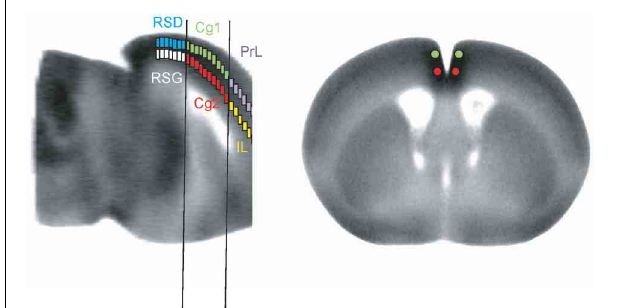
FIGURE 1 | Representation of region-of-interest selections (not to scale) in the cortical midline